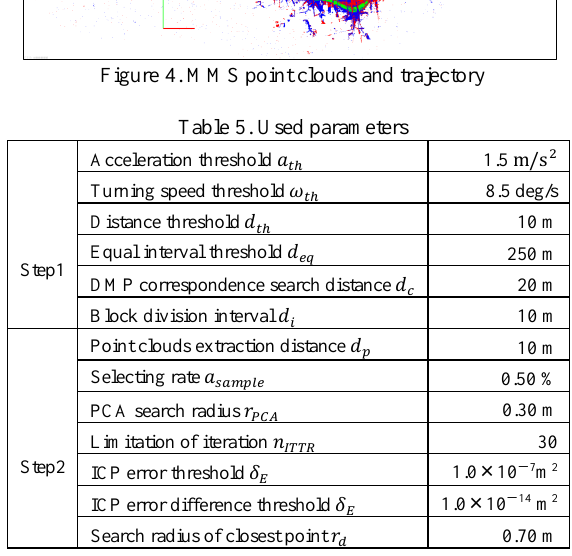
(b) Side view of utility pole at position B in Figure 6